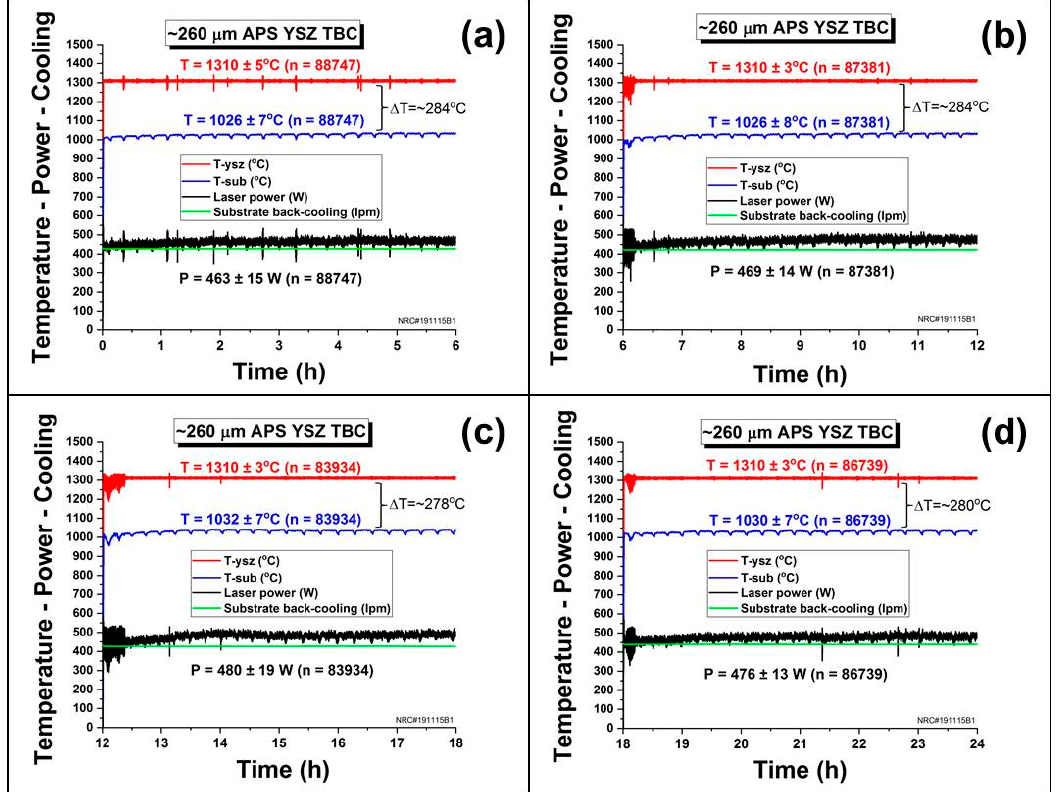
Figure 8. Laser-rig thermal gradient results for the ~260 µm thick porous APS YSZ TBC: ( a ) 0–6 h; ( b ) 6–12 h; ( c ) 12–18 h; ( d ) 18–24 h.